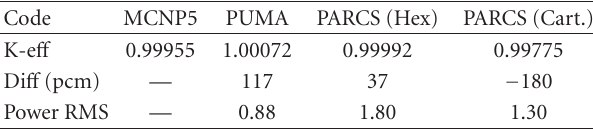
Table 6: CNA-II idealized core—unrodded.